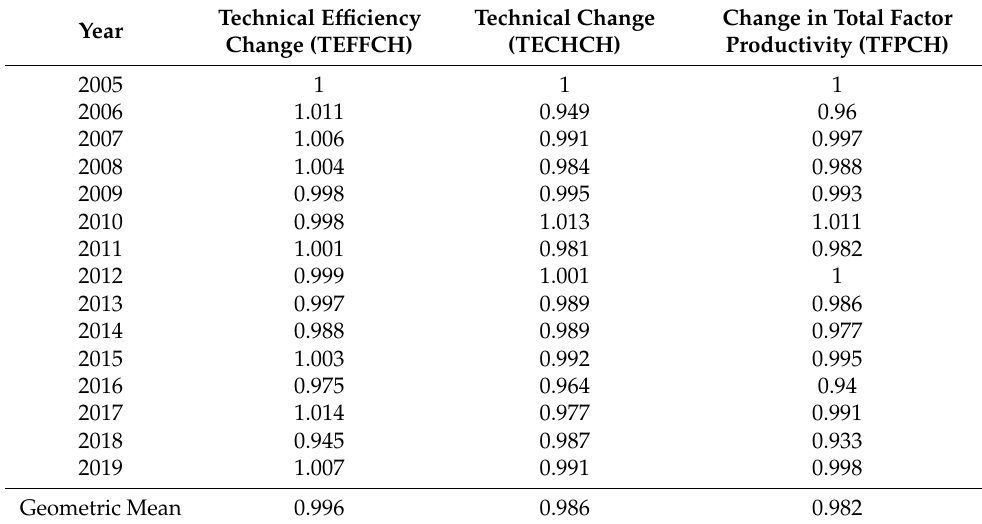
Table 2. MPI summary of annual means, during